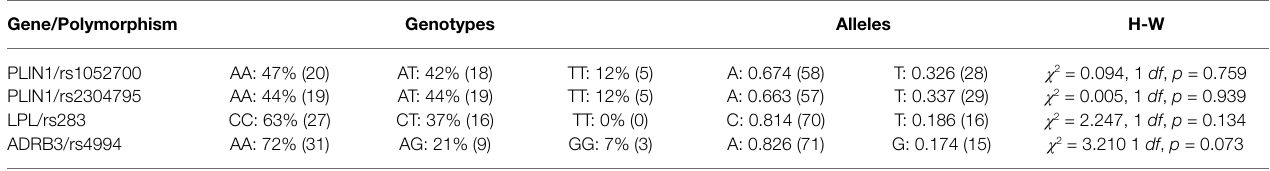
H-W, Hardy–Weinberg equilibrium. Number in parenthesis indicates number of individuals from the total sample studied (N = 43).